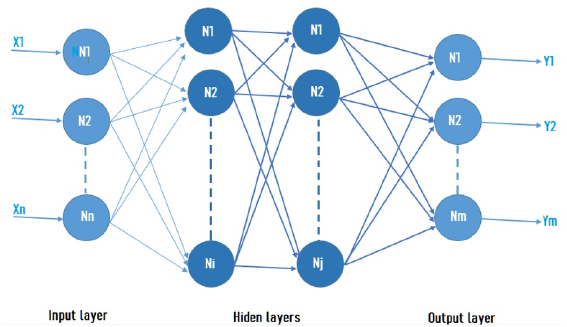
Figure 3. Representation of an ANN with n inputs and m